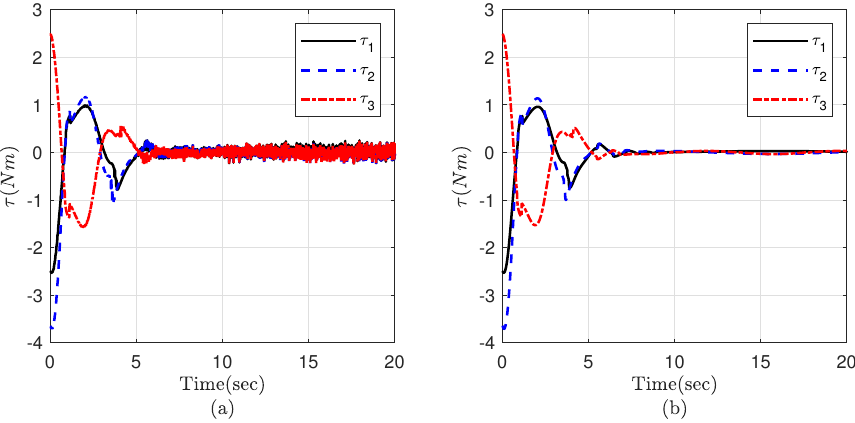
Figure 19. The control torque in Part 3: ( a ) noisy measurement, ( b ) high-frequency